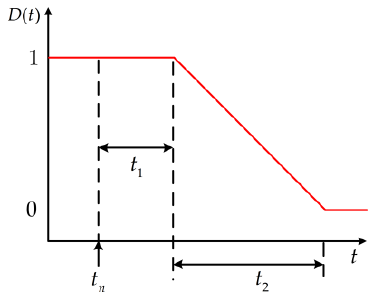
Figure 4. Deactivation function for the integral controller.